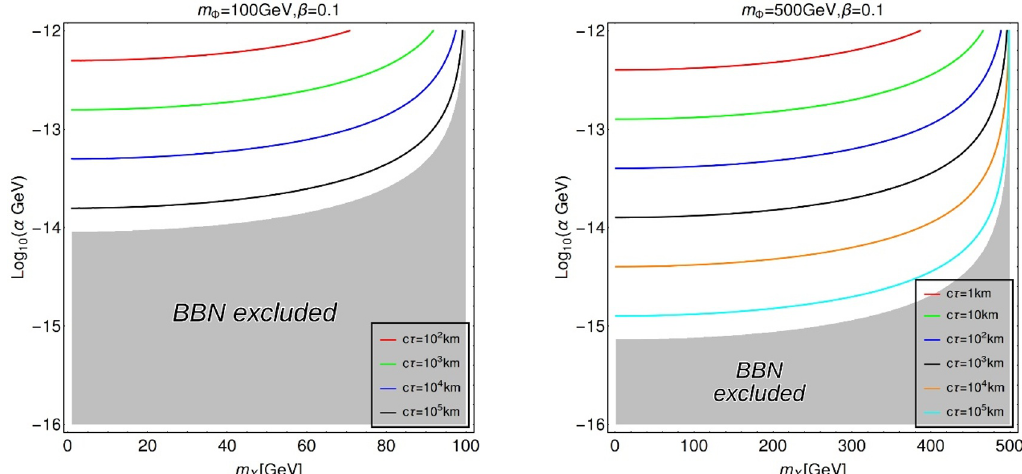
Figure 13 . The contours show different decay lengths of Φ for particular choices of the parameters that can produce right relic abundance for the DM. On left panel, we choose m Φ = 100 GeV, while on the right panel we show the case for m Φ = 500 GeV. The shaded region at the bottom is excluded by BBN constraint τ Φ < ∼ τ BBN ∼ 1 sec .